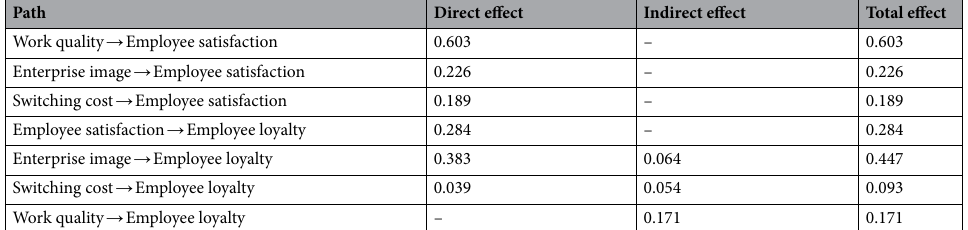
Table 7. Direct, indirect, and total effects of employee satisfaction and employee loyalty. The total effect of one construct on another is the sum of the direct effect and indirect relationships between them. The indirect effect is computed by multiplying the direct effects by each other, e.g., the indirect effect of Work Quality → Employee Loyalty is computed as 0.603 × 0.284 =